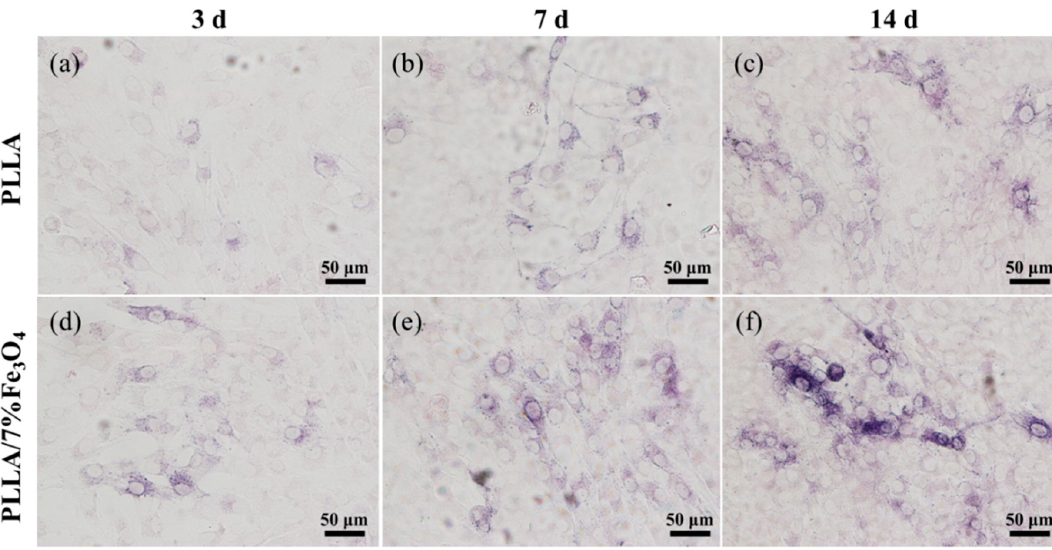
Figure 8. ALP activity staining diagram of MG63 cells on the scaffolds. ( a ) 3 days on the PLLA scaffold, ( b ) 7 days on the PLLA scaffold, ( c ) 14 days on the PLLA scaffold, ( d ) 3 days on the PLLA/7% Fe 3 O 4 scaffold, ( e ) 7 days on the PLLA/7%Fe 3 O 4 scaffold, ( f ) 14 days on the PLLA/7% Fe 3 O 4 scaffold.